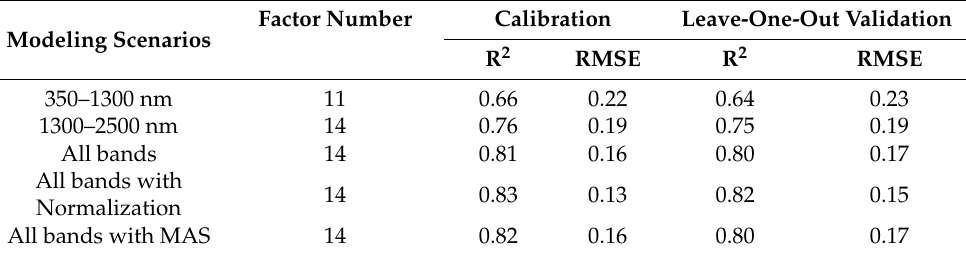
Table 3. Modeling results of partial least squares regression with different regions, pretreatments. Modeling